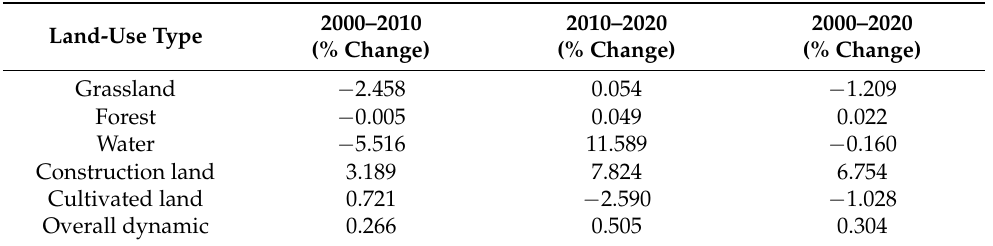
Table 5. Land-use dynamic in the ECA of western Beijing from 2000 to 2020 for each land-use type and for the overall landscape dynamic.